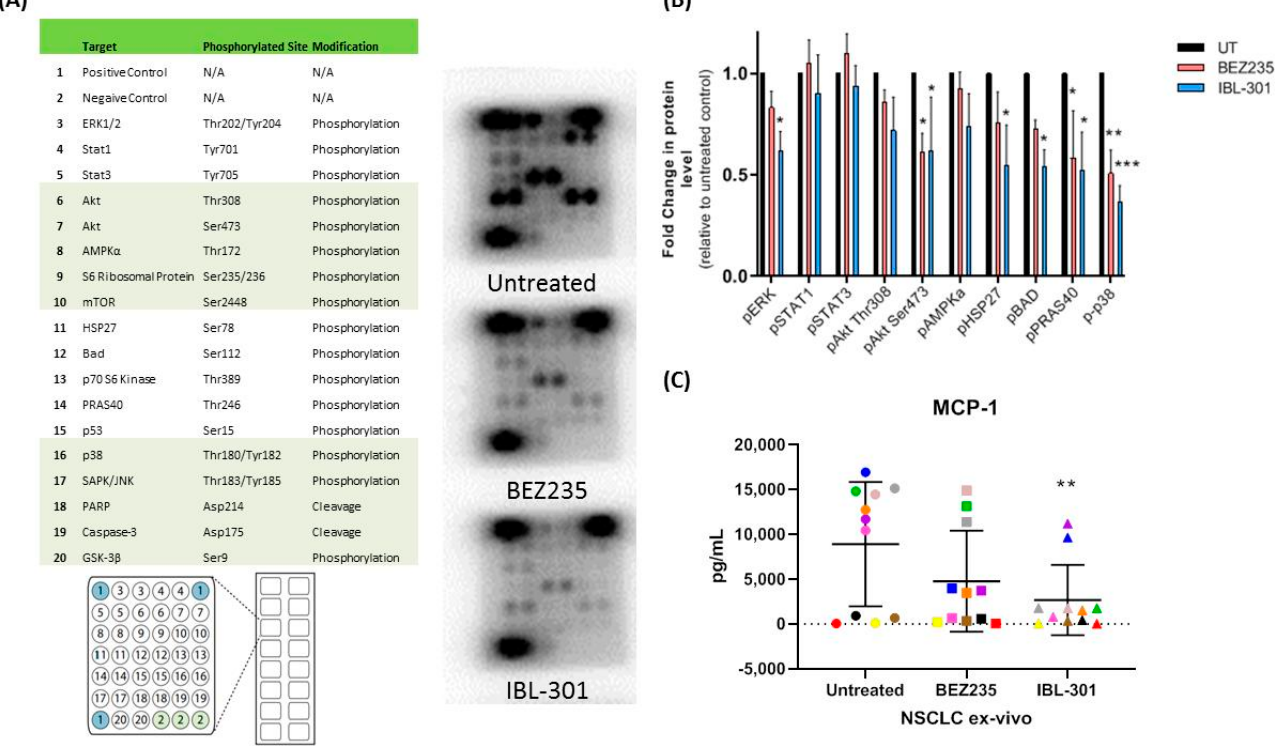
Figure 2. Targeting PI3K/mTOR or PI3K/mTOR/PIM in NSCLC explant tissue. ( A ) NSCLC tumor explants were cultured ex vivo for 72 h with DMSO vehicle control, 250 nM BEZ235 or 250 nM IBL-301 and protein was extracted and assayed using a PathScan ® intracellular signaling array ( n = 3). ( B ) Ten out of eighteen proteins as indicated were detectable, IBL-301 was more effective at altering the phosphorylation profile of the NSCLC tumor than BEZ235. IBL-301 significantly decreased pERK, pAkt (Ser473), pHSP27, pPRAS40 and p-p38 while BEZ235 significantly decreased pAkt (Ser473), pPRAS40 and p-p38 (two-way ANOVA with Dunnett’s multiple comparisons test was used, * p < 0.05, ** p < 0.01, *** p < 0.001). ( C ) Tissue conditioned media from cultured NSCLC explants were assayed for MCP-1 levels using a magnetic bead based immunoassay (MILLIPLEX MAP) ( n = 11) and IBL-301 significantly decreased MCP-1 secretions (one-way ANOVA, p < 0.01).